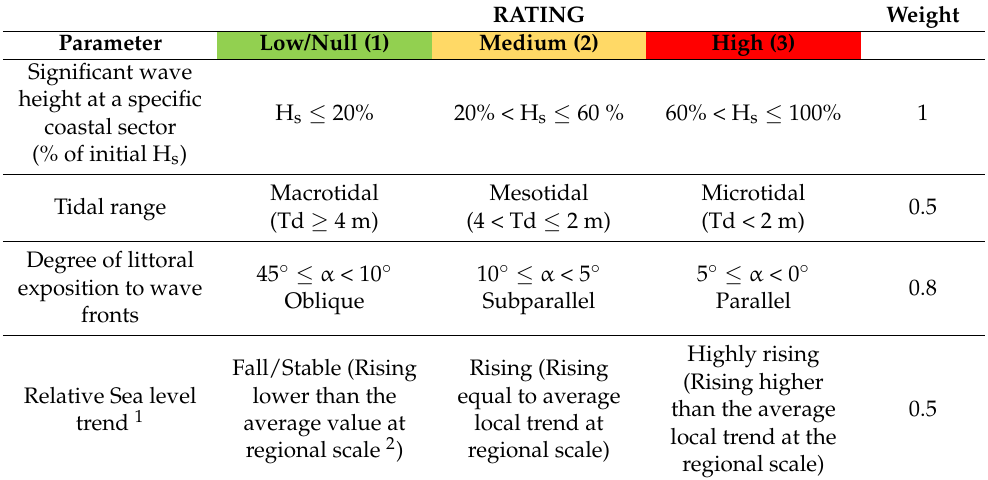
Table 3. Coastal Forcing Index rating from 1 – minimum (green) to maximum (red) forcing values.